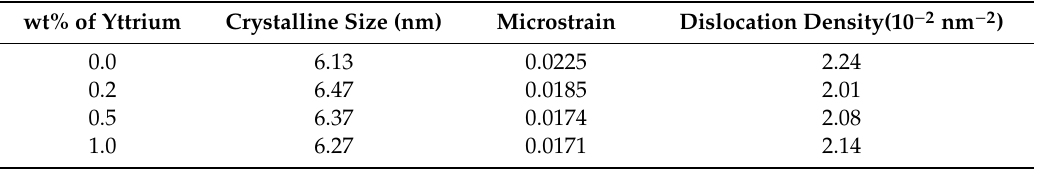
Table 1. Crystalline size, microstain, and dislocation density of Y-doped SnO 2 semiconductor films with different Ywt%.